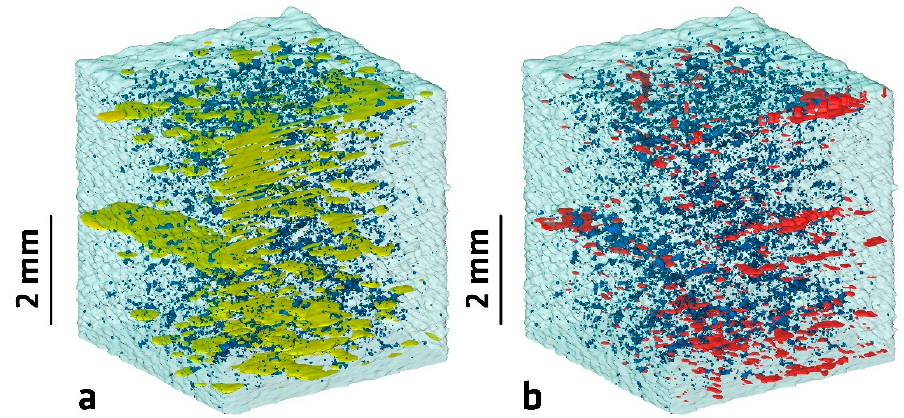
Figure 12. Rendering of the transparent surface with overlap of defects detected in µCT, thermography and optical tomography in Volume B. ( a ) Blue–µCT defects, yellow—thermography irregularities of TOT (700 K) greater than 30 ms; ( b ) red—optical tomography with more than 700 DV. Table 5. Binary volumetric overlap of segmented pores from µCT data and anomalies detected by thermography (TOT (700K) > 30 ms) and OT (OT signal > 700 DV), where the relative cumulative volumes compared with respect to cumulative pore volume are 90% for thermography and 8% for OT.